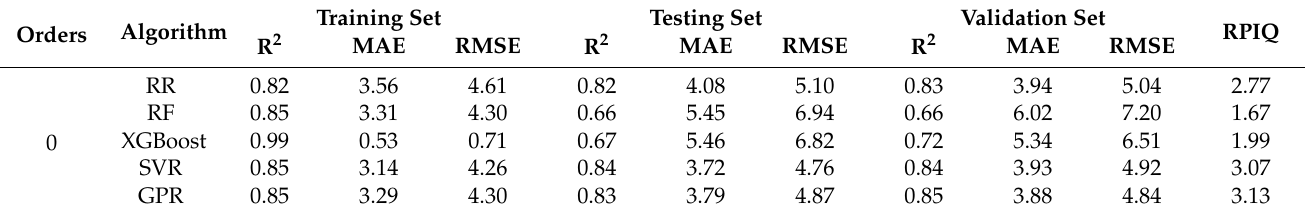
Table 4. Results of accuracy indicators for all MLRAs based on the hyperspectral datasets (0–2 order), the units of MAEs and RMSEs are µ g · cm − 2